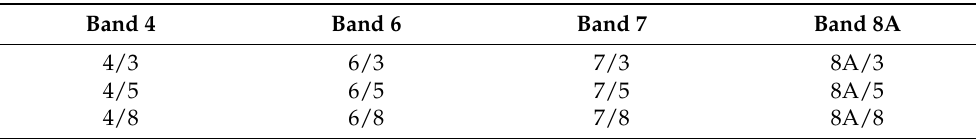
Table 2. BR developed through spectral analysis of spectra extracted from Sentinel 2 bands. The spectra were organised according to reflectance bands.